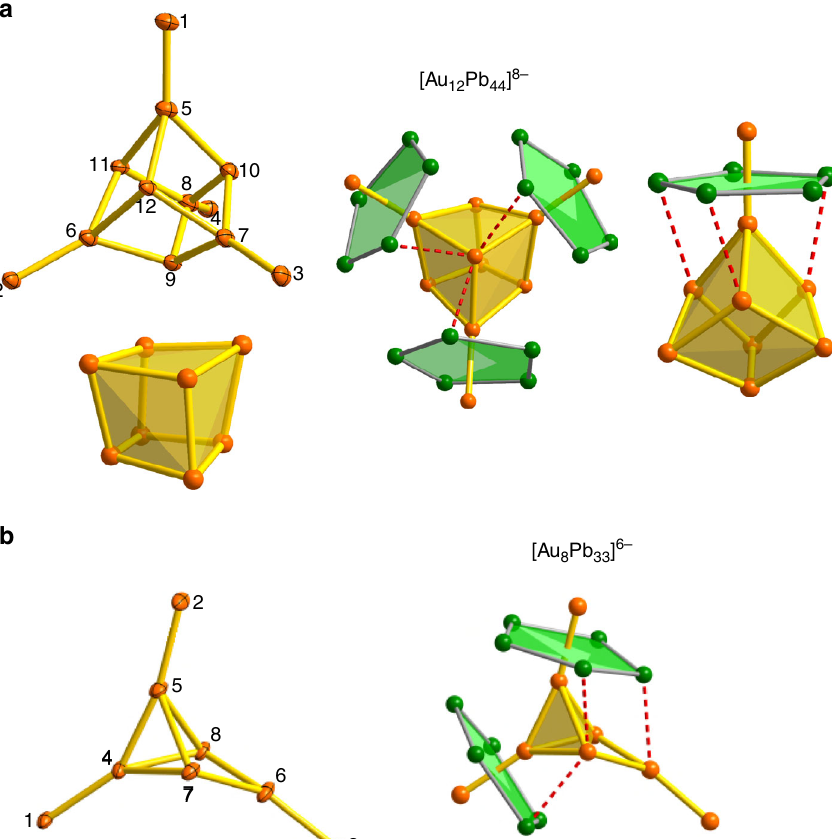
Fig. 4 Structures of the Au x cores in [Au 12 Pb 44 ] 8 − and [Au 8 Pb 33 ] 6 − . a the Au 12 core in [Au 12 Pb 44 ] 8 − and b the Au 8 core in [Au 8 Pb 33 ] 6 − . Red dashed lines emphasize the secondary Au … Pb π interactions at ~ 3.60 Å between the capping Au atoms and the Pb 5